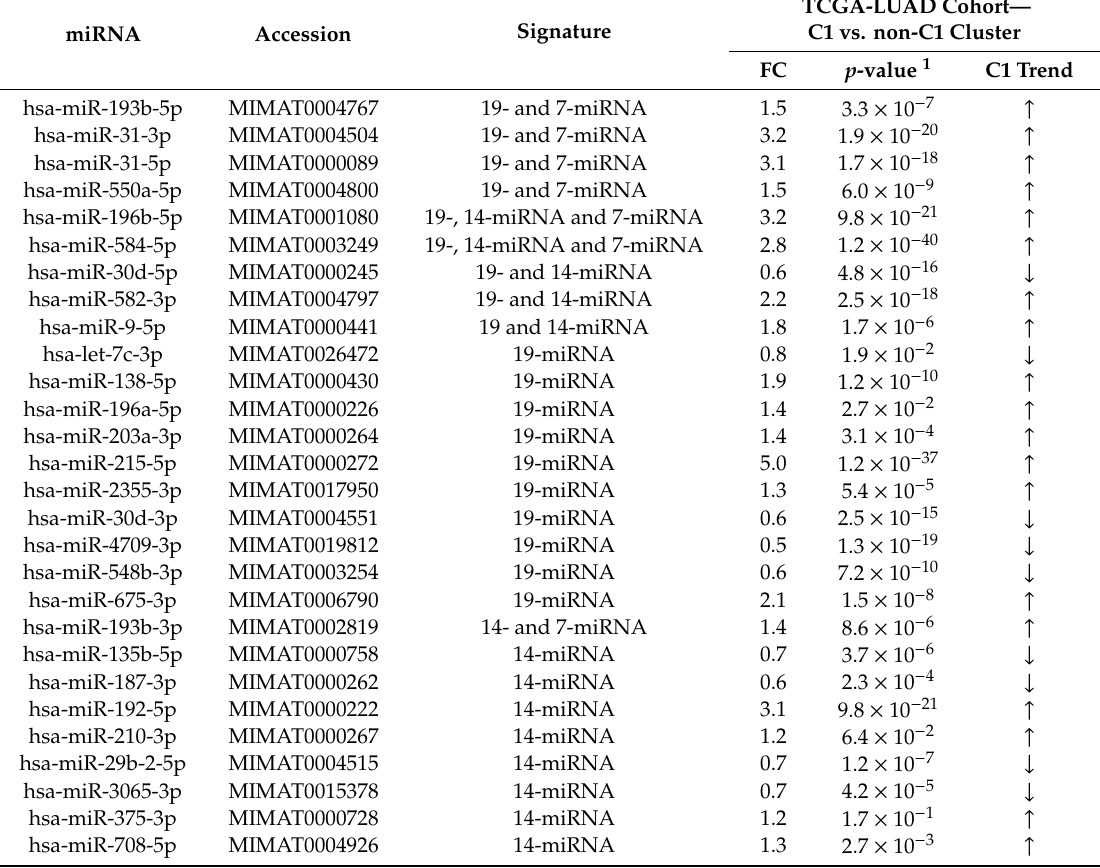
Table 2. TCGA-LUAD cohort. Di ff erentially expressed miRNAs composing the three signatures with 19, 14 and 7 miRNAs.